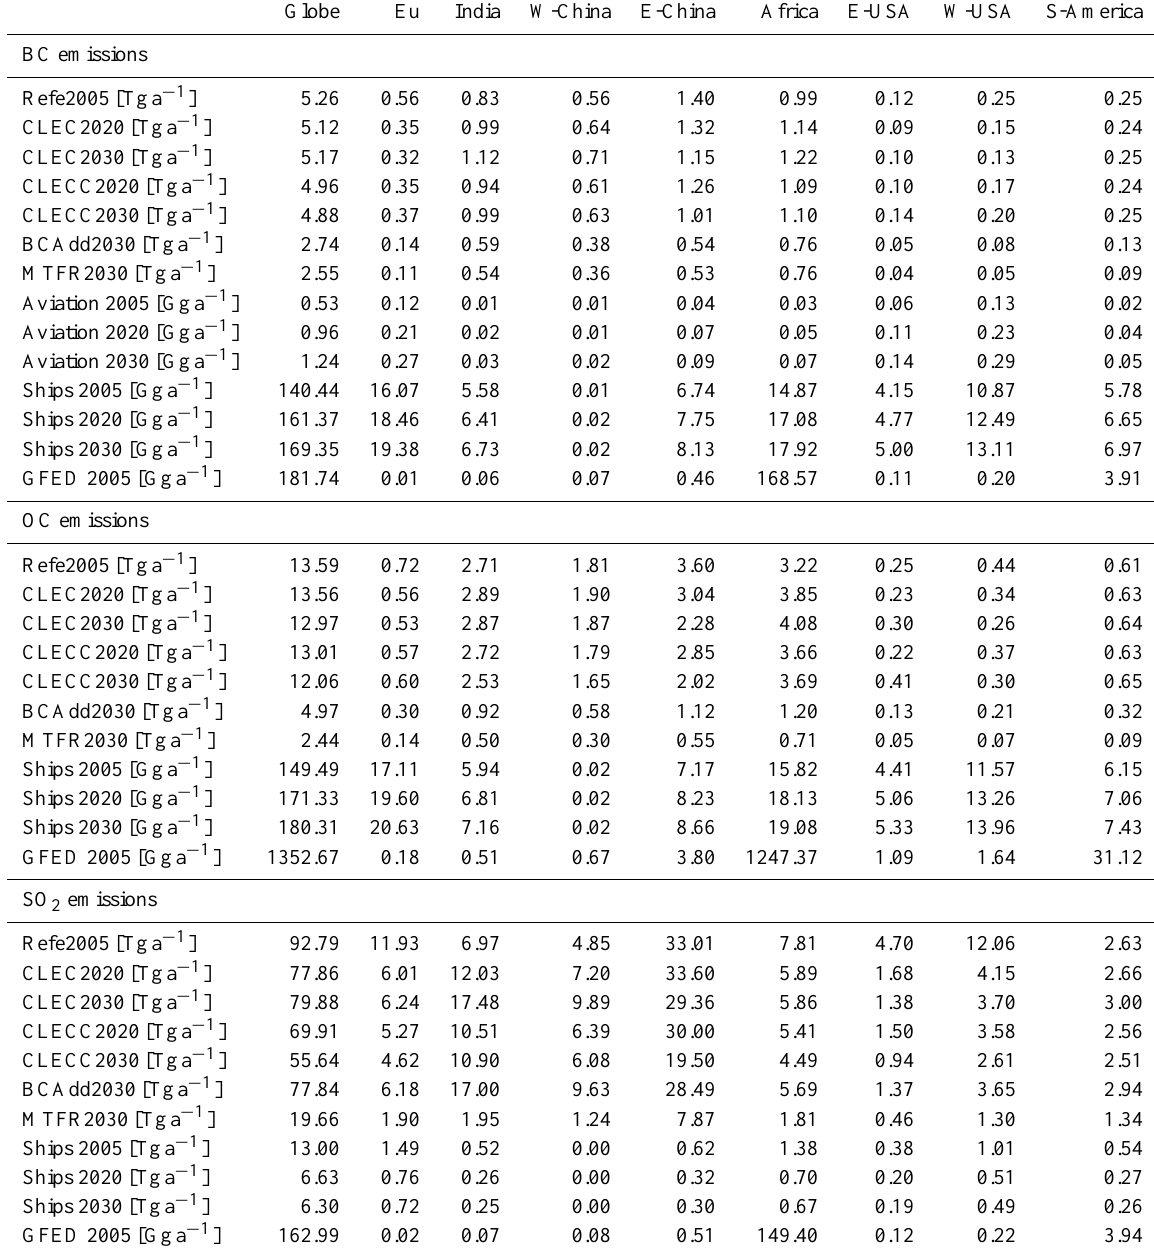
Table 1. Yearly emissions fluxes for different sources, continental anthropogenic emission scenarios and aerosol species (GFED denotes the wildfire emissions): black carbon (BC), organic carbon (OC) and sulfuric dioxide (SO 2 ). The different geophysical areas are shown in Fig. 1. Note: the GFED emissions do not include agricultural waste burning sector because it is included in the GAINS emissions. Globe